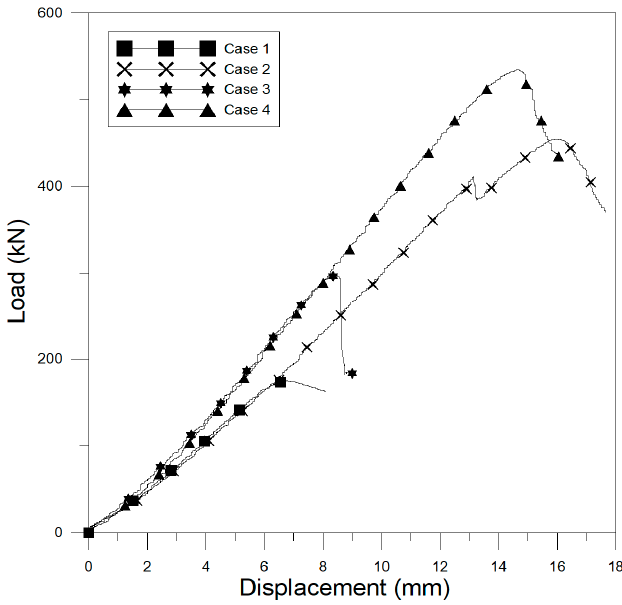
Figure 4. Failure shape of prefabricated shoring system installation for Cases 1–4.